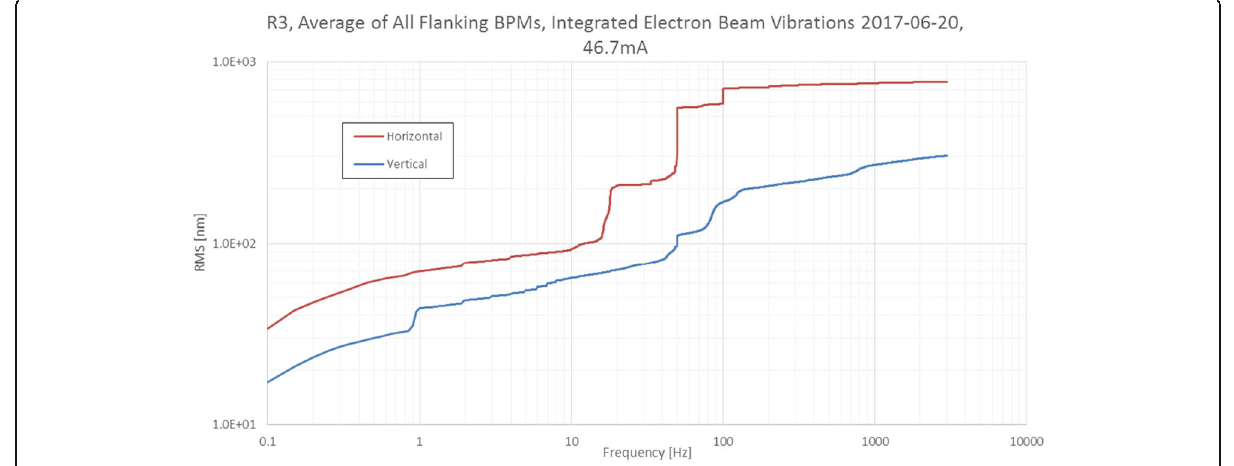
Fig. 16 Beam oscillation spectrum in MAX-IV